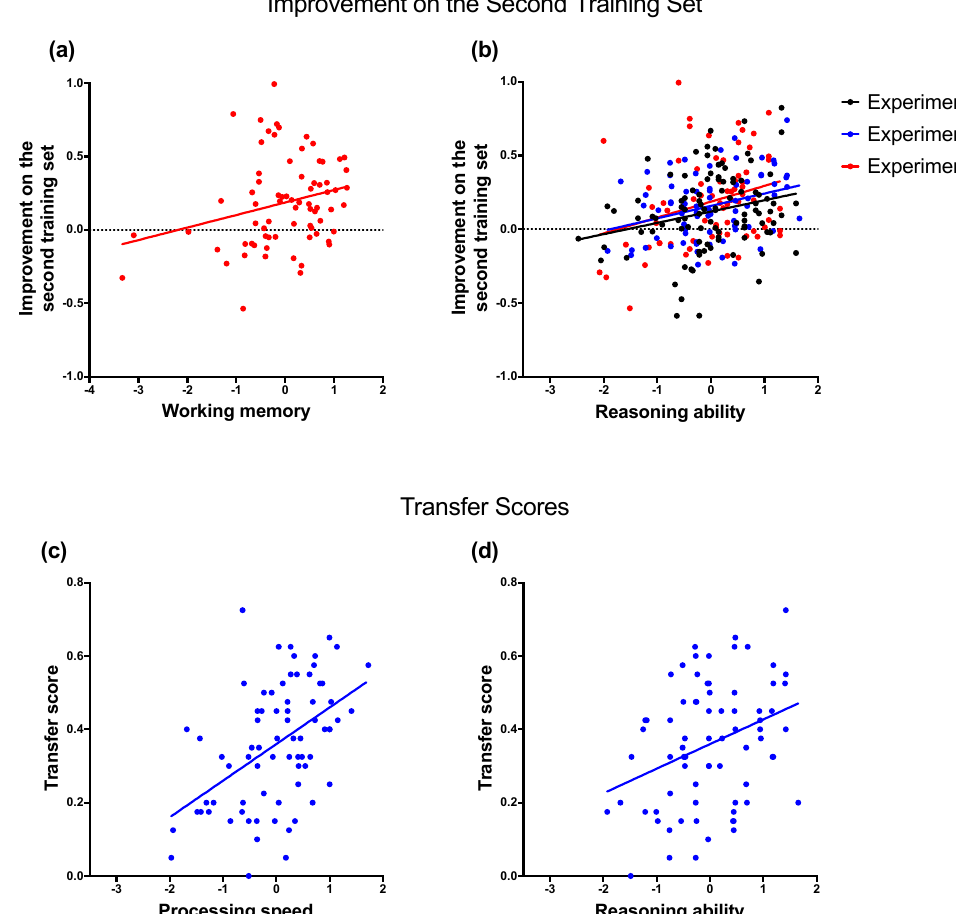
Figure 3. Scatter plots showing the correlations between learning measures and fluid abilities that were significant predictors after controlling for at least age and gender (Table 4). The upper panels illustrate the relationship between the improvement on the second training sets and ( a ) working memory in Experiment 3 and ( b ) reasoning ability in Experiment 1–3. The lower panels illustrate the relationship between the transfer scores in Experiment 2 and ( c ) processing speed and ( d ) reasoning ability.